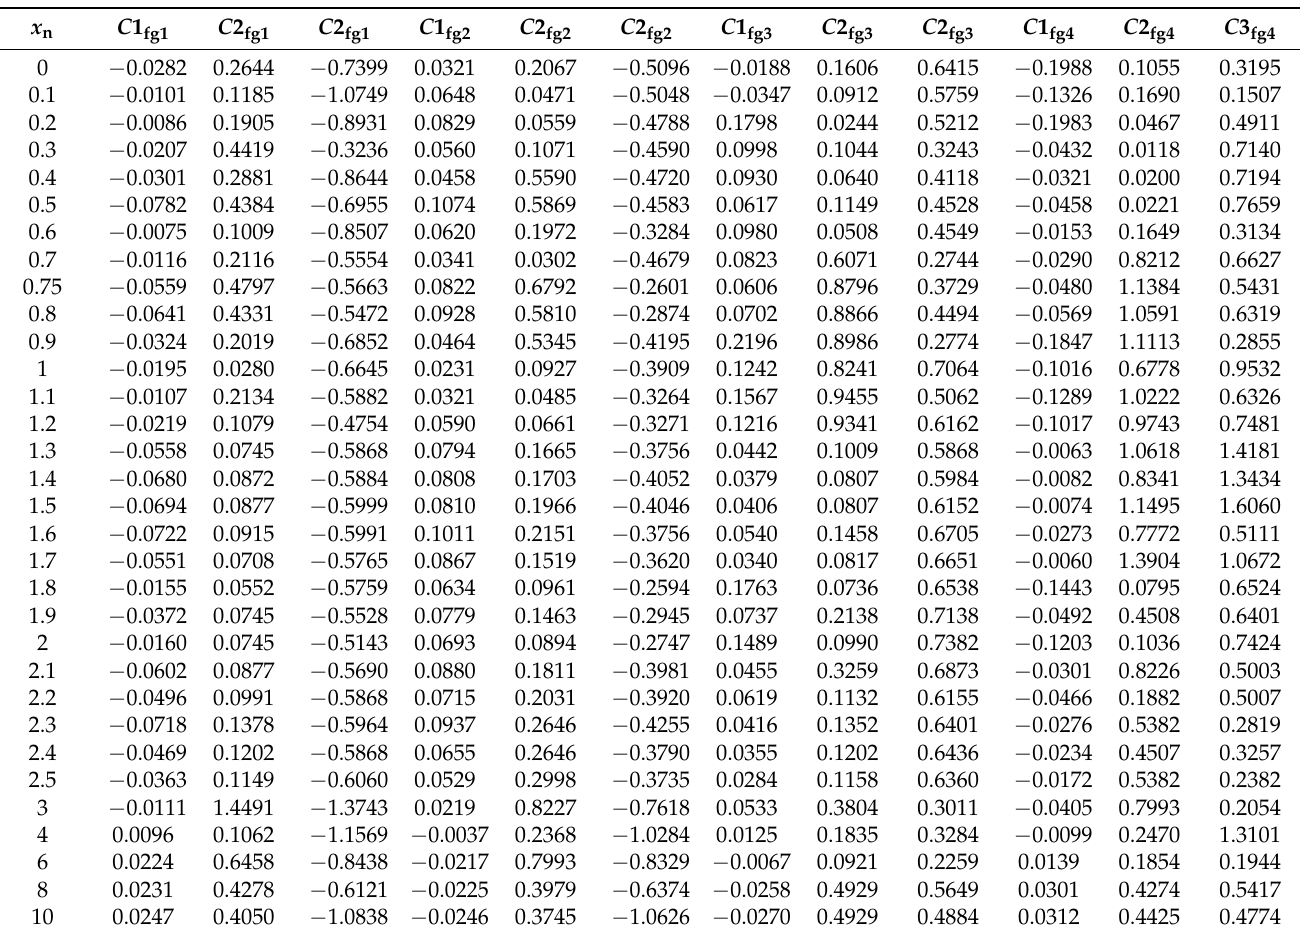
Table A4. The fitting parameters in Gaussian-type functions, f G_ i , ( x n ≥